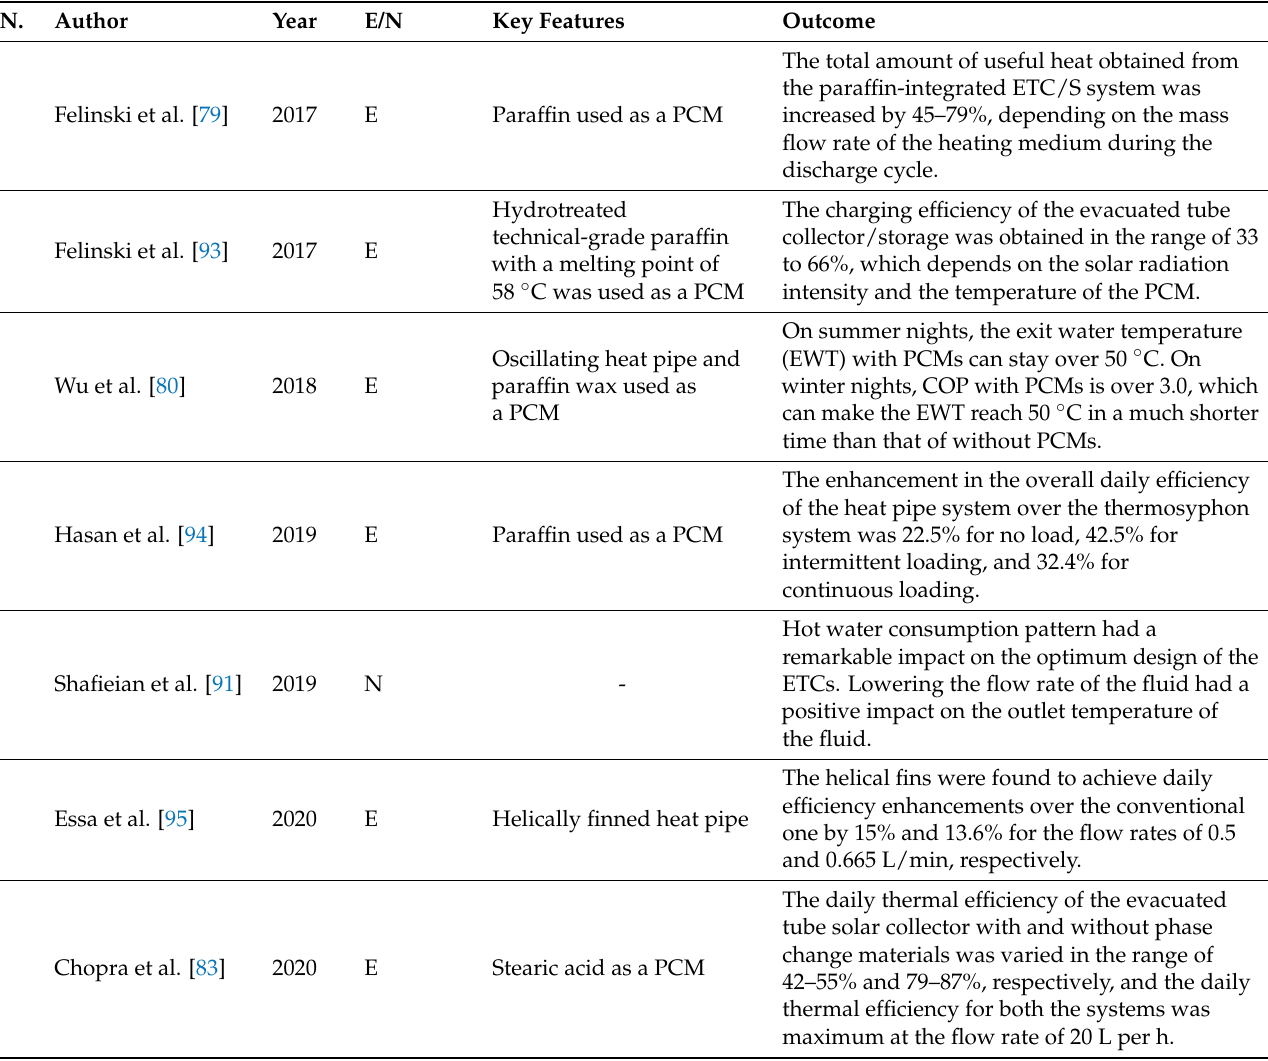
Table 3. Summary of investigation on heat pipe ETC-PCM/nanofluid-based